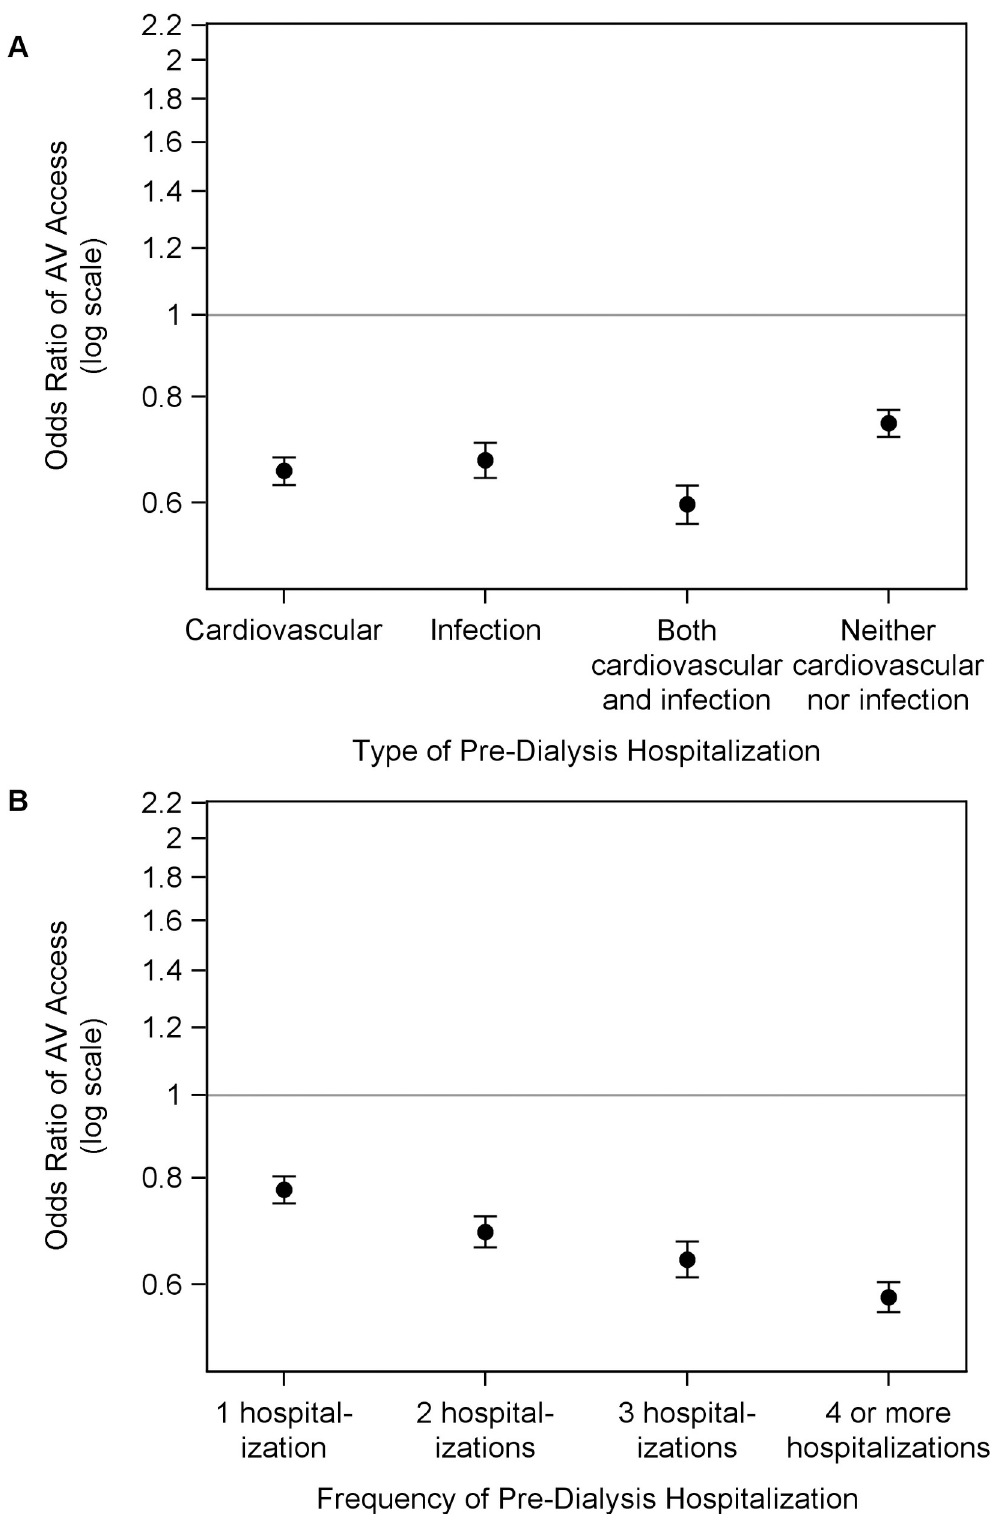
Fig 5. Association of pre-dialysis hospitalization with use of AV access for initiation of hemodialysis among patients with ESRD. Adjusted odds ratio for probability of AV access use vs. central venous catheter to initiate hemodialysis by (A)